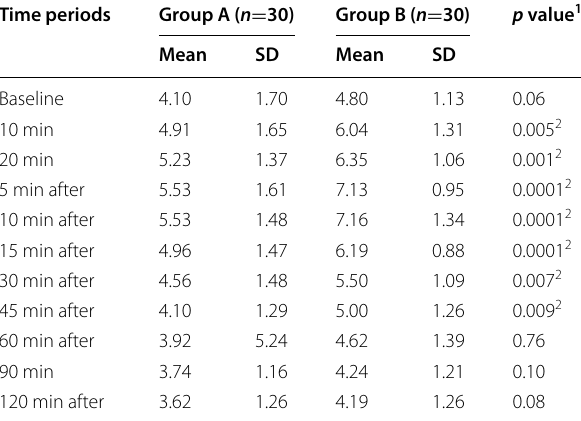
Table 4 Comparison of cardiac output (CO) between the groups across the time periods